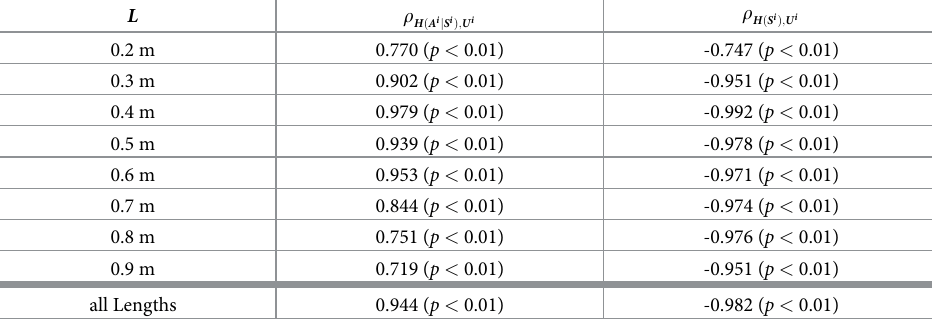
Table 1. Action and state entropies’ Spearman coefficients ( r lengths L .